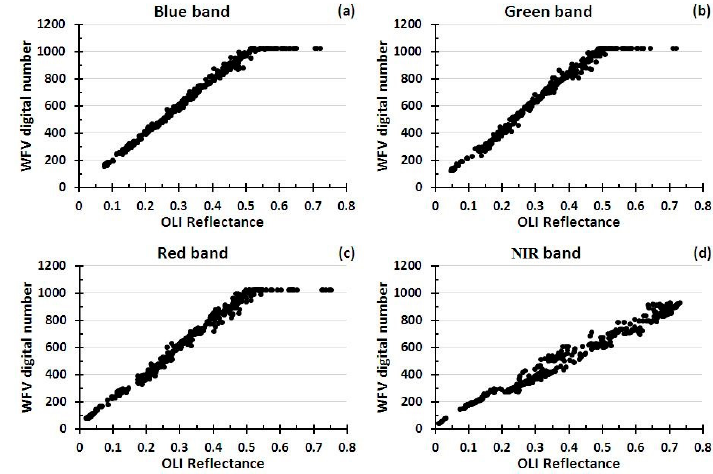
Figure 3. Landsat-8 OLI reflectance plotted against Gaofen-1 WFV3 digital number (DNs) for the four spectral bands of WFV3: ( a ) Blue band; ( b ) Green band; ( c ) Red band; and ( d ) NIR band. The WFV3 DNs increases monotonically with the elevated OLI reflectance over a large reflectance coverage (0–0.5). Note that the 10-bit WFV data saturate at